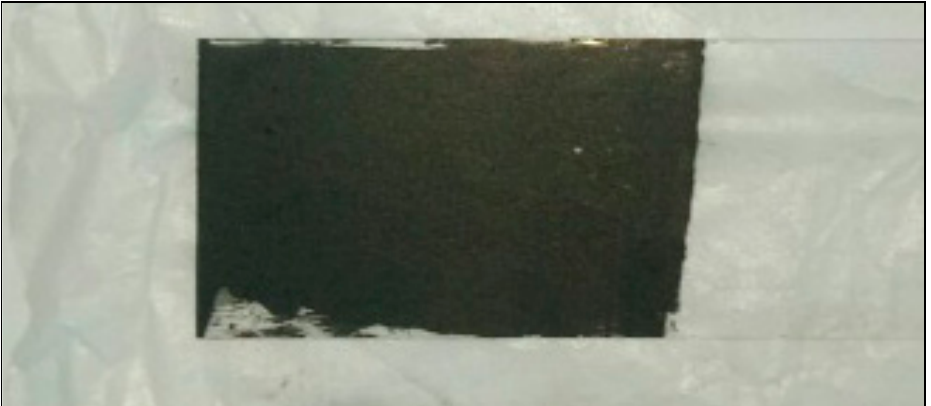
Figure 1. Thin-film of castor oil-emitted powder for characterization.